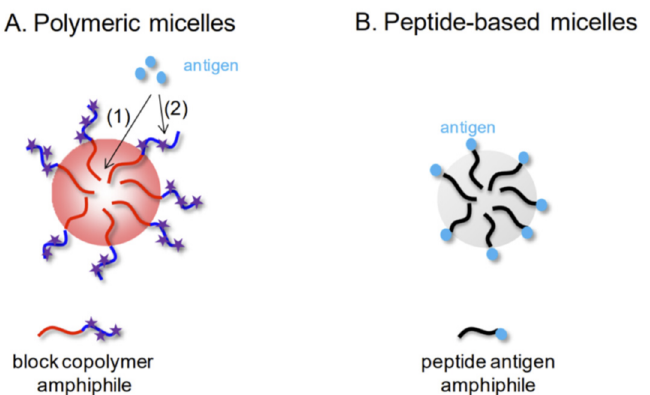
Figure 2. Schematical representation of the micellar nanoparticles developed as vaccine adjuvants: ( A ) polymeric micelles obtained by self-assembly of amphiphilic block copolymers in water, in/on which the antigenic peptide is encapsulated (1) or surface-coupled (2) (reactive groups represented by star symbols); ( B ) micelles obtained from self-assembly of peptide antigen amphiphiles in water. (Adapted from